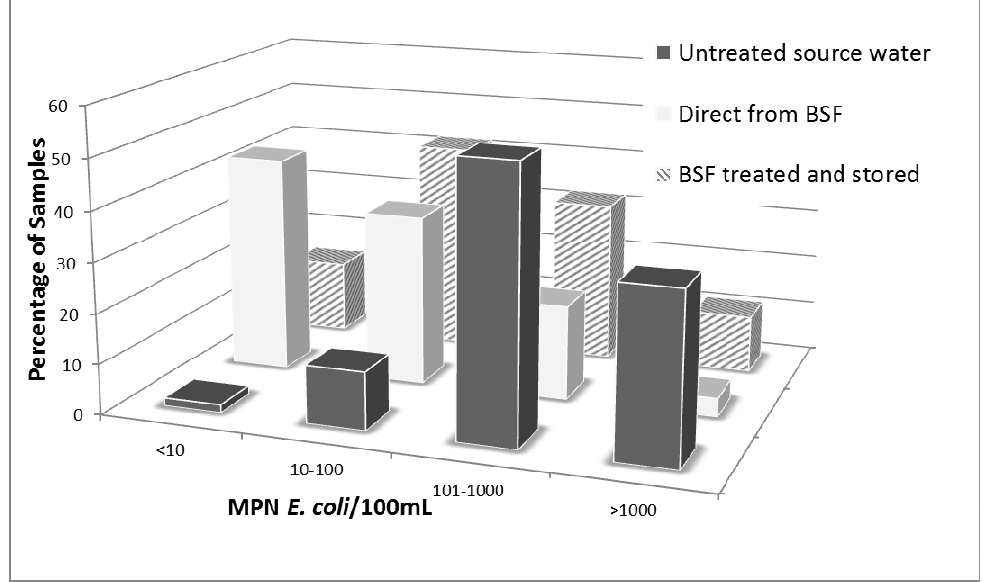
Figure 3 . Comparison of categorical E. coli concentrations in different water samples from plastic BSF households during intervention period of the RCT of the plastic BSF in rural Tamale, Ghana